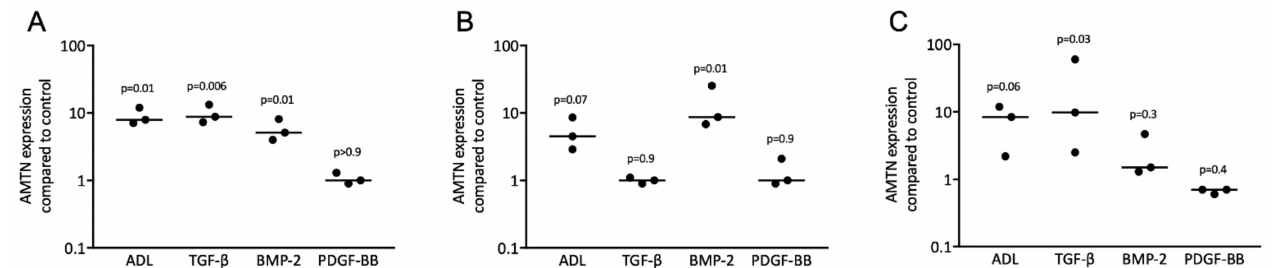
Figure 3. TGF- β and BMP-2 upregulate AMTN. RT-PCR analysis of the AMTN gene in the presence of ADL, TGF- β , BMP-2, and PDGF-BB showed upregulation induced by TGF- β and BMP-2 in ( A ) HSC2, while for ( B ) TR146 only BMP-2 and for ( C ) GF only TGF- β increased AMTN expression, in comparison to the untreated controls. Statistics based on one-way ANOVA Kruskal–Wallis